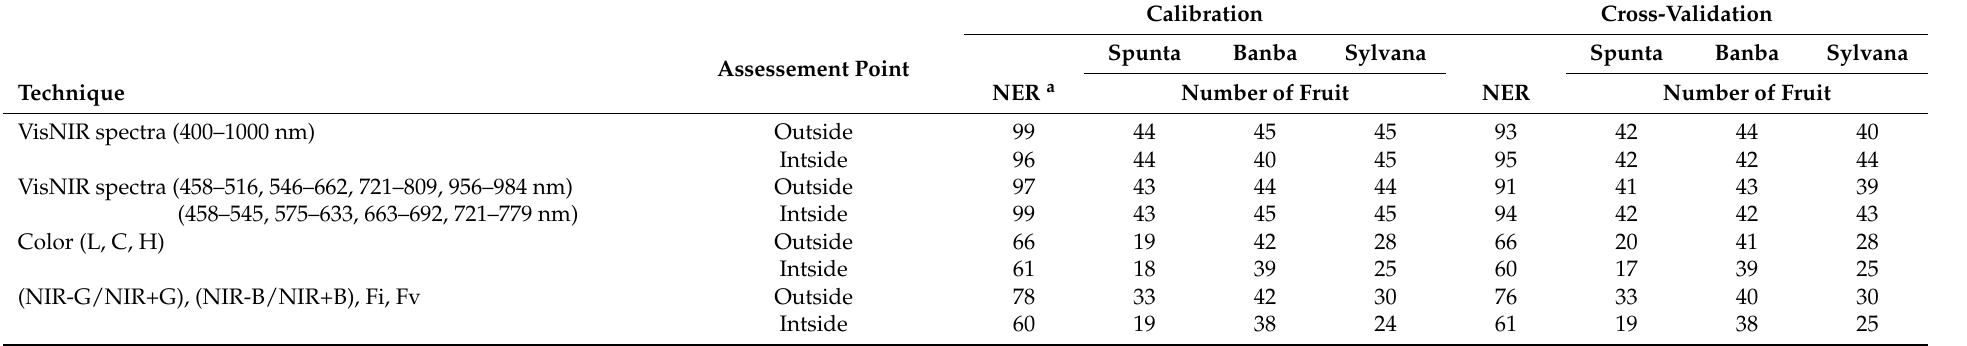
Table 2. Calibration and cross-validation classification of correctly discriminated potatoes into the three cultivars (Spunta, Banba, or Sylvana) using the partial least squares discriminant analysis (PLSDA) classifier from color, digital imaging, and chlorophyll fluorescence as well as Vis/NIR spectroscopy data of the whole 400–1000 nm region, as well as from the selected regions upon the genetic algorithm